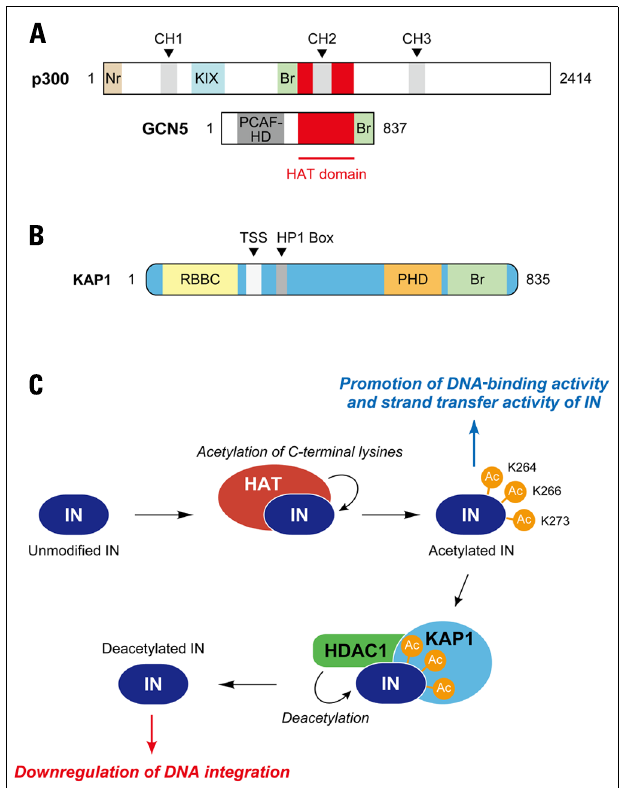
FIGURE 4 | Regulation of HIV-1 integration by acetylation and deacetylation of IN. (A) Acetyltransferases for HIV-1 IN. p300 and GCN5 have been identified as cellular enzymes catalyzing acetylation of HIV-1 IN. Both proteins are members of histone acetyltransferase (HAT) family, which transfer an acetyl group from acetyl coenzyme A to specific lysine residues on substrate proteins; HATs function as transcriptional co-activators in the nucleus. Although a conserved HAT domain is indispensable to acetylation activity of HATs, other domains including bromodomain (Br) apparently have effects on their function. p300 is able to bind a variety of transcription factors through cysteine-histidine-rich module (CH1, CH2, and CH3) and KIX domain. Nr, nuclear receptor-interacting box; PCAF-HD, PCAF homology domain. (B) Schematic of KAP1. KAP1, also known asTRIM28, is highly related to three otherTRIM proteins,TIF1 α , TIF1 γ , andTIF1 δ .TheTIF proteins, including KAP1, exhibit similar domain organization, which includes RBCC (Ring/B-box/coiled coil) domain at the N-terminal,TIF1 signature sequence (TSS) and heterochromatin protein 1 (HP1)-binding domains at central portion, and plant homeodomain (PHD) and bromodomain (Br) at C-terminal. (C) Restriction of HIV-1 integration by KAP1. Cellular acetyltransferase (HAT) such as p300 interacts with HIV-1 IN and catalyzes acetylation of the IN.Three lysine residues in CTD of IN (Lys-264, Lys-266, and Lys-273) have been reported as target sites for p300 and GCN5.The acetylation appears to enhance the DNA-binding activity and strand transfer activity of IN. In a proposed model, KAP1 specifically recognizes the acetylated form of IN and induces a protein complex formation with histone deacetylase (HDAC), resulting in deacetylation of IN and reduced integration